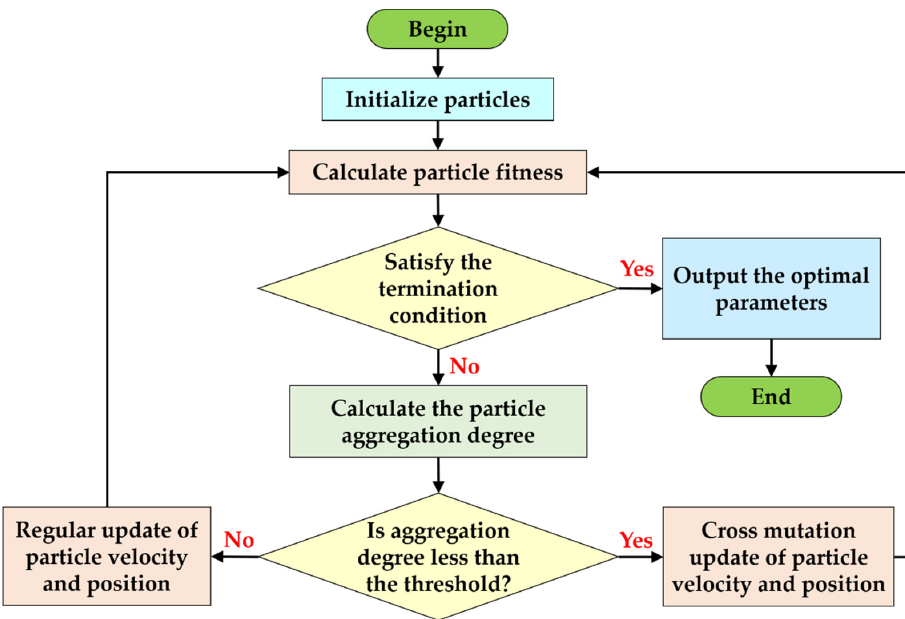
Figure 5. The framework of IPSO algorithm for SVR parameter optimization.